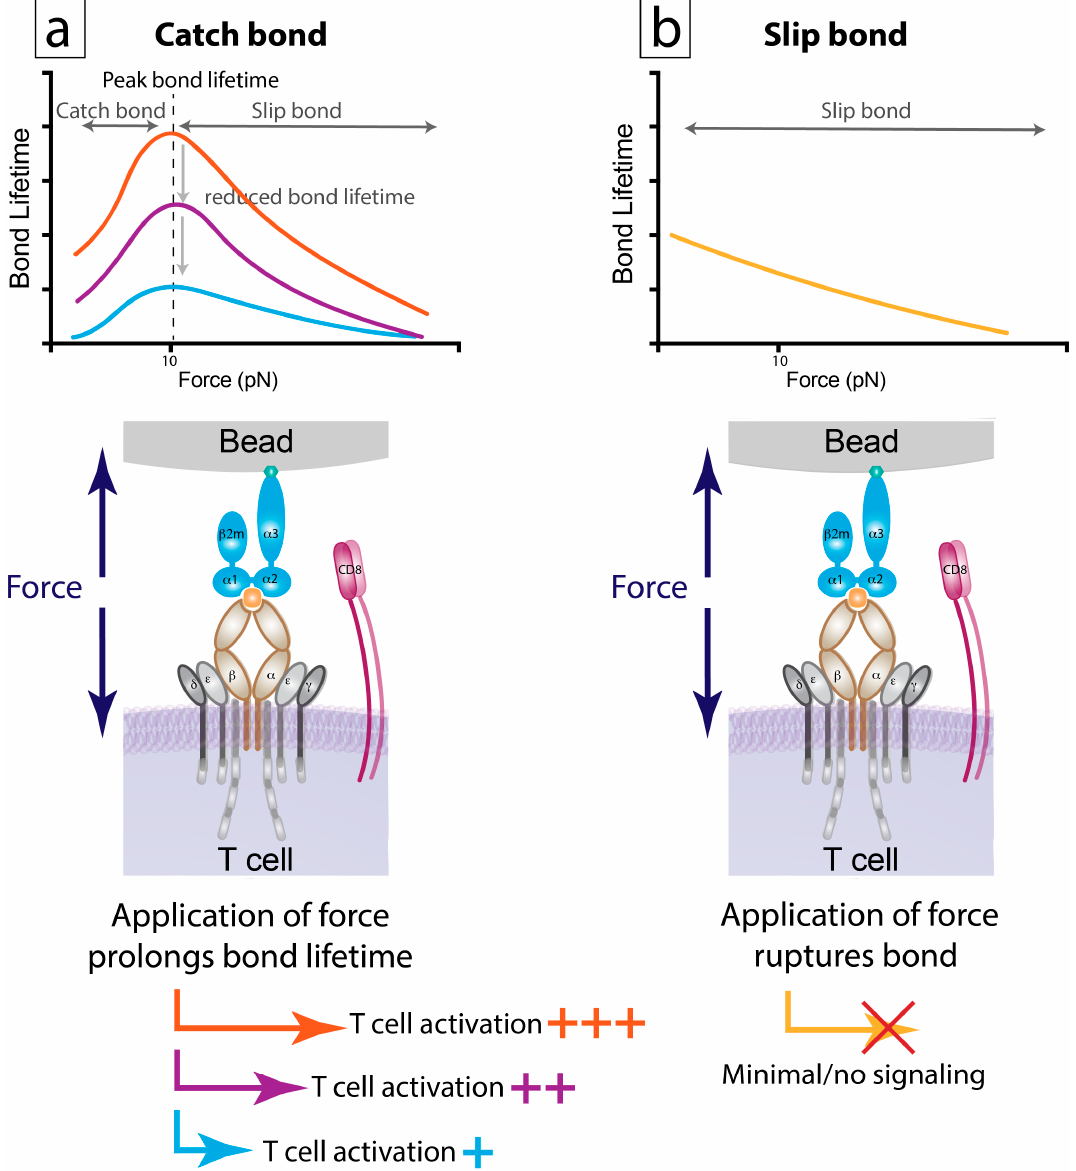
Figure 4. Catch versus slip bonds. ( a ) Catch bonds: As increasing amounts of force are applied to the TCR:pMHC complex bond lifetime increases until a pinnacle is reached. Continuing to increase force at this point results in decreases bond lifetime creating a catch bond. 10pN has been demonstrated to be peak force. Longer peak bond lifetimes result in increases T cell signaling. ( b ) A slip bond: as force is increased, bond lifetime decreases. Slip bonds generate minimal to no